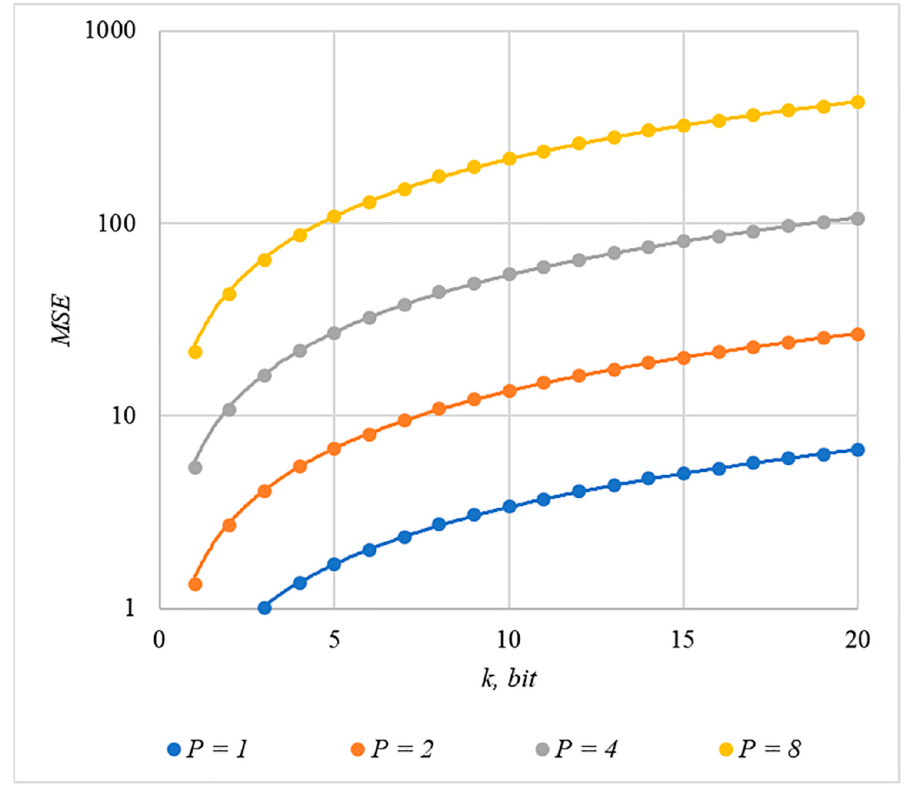
P rule for generating chip codes № 2. Figure 11. MSE ( k ) dependencies for different values of